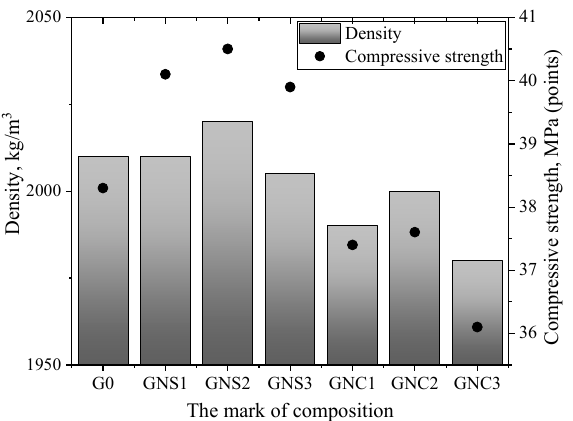
Figure 14. Results of compressive strength and density of cement pastes after 3 days of hardening. The decrease in strength was observed with the addition of NC compared to the reference. The sample containing 0.20 wt.% of NC (GNC3) showed the highest reduction in this mechanical property with the strength being 5.7% lower than the compressive strength of the control sample. The comparison of the compressive strength values presented in Figure 14 (points) with the density values (columns) show the same nature of the variation of these charac- teristics. The nano admixture had a slight impact after hardening (from 10 to 30 kg/m 3 ), whereas a more visible impact of nano admixtures (from 100 to 150 kg/m 3 ) was observed after 3 days compared to the control sample. The measurements of the total porosity and pore size distribution for characteristic CAC samples are presented in Figure 15a,b.